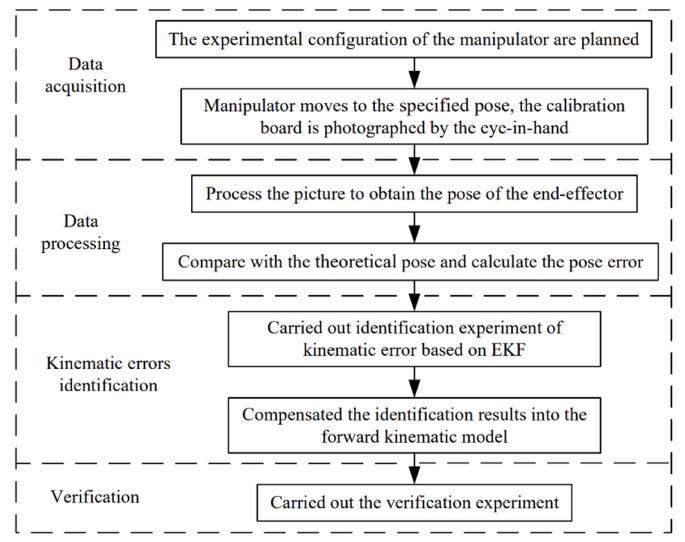
Figure 5. Identification